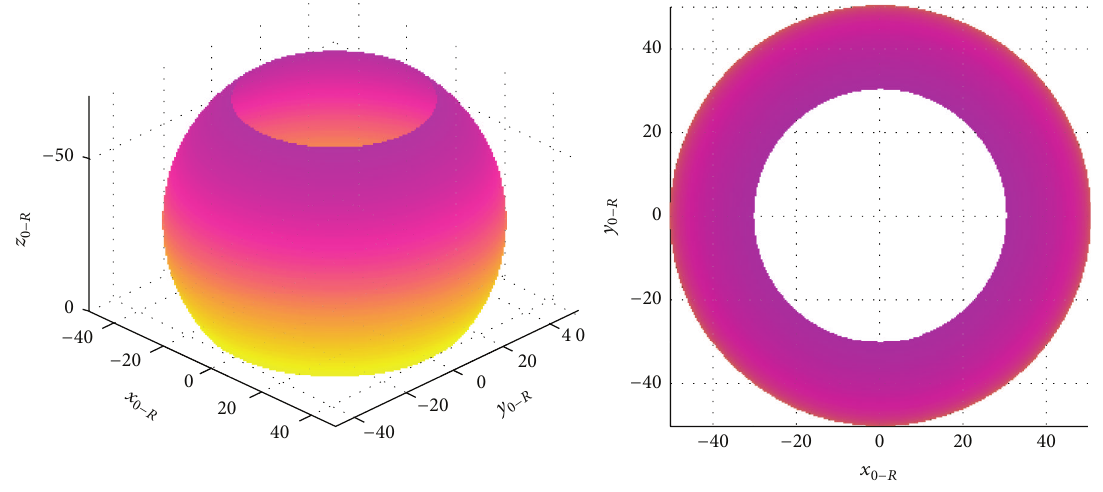
Figure 3: Shape of envelope surface.